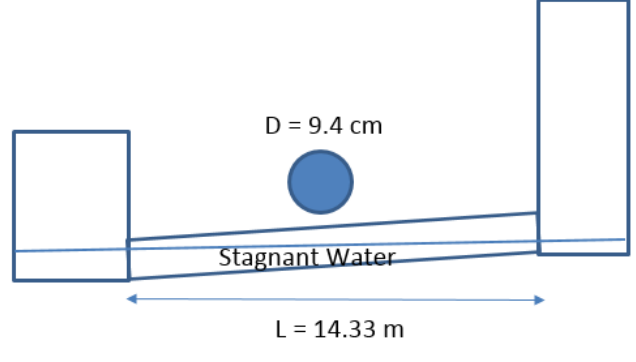
Figure 8. Schematic of test case 3.